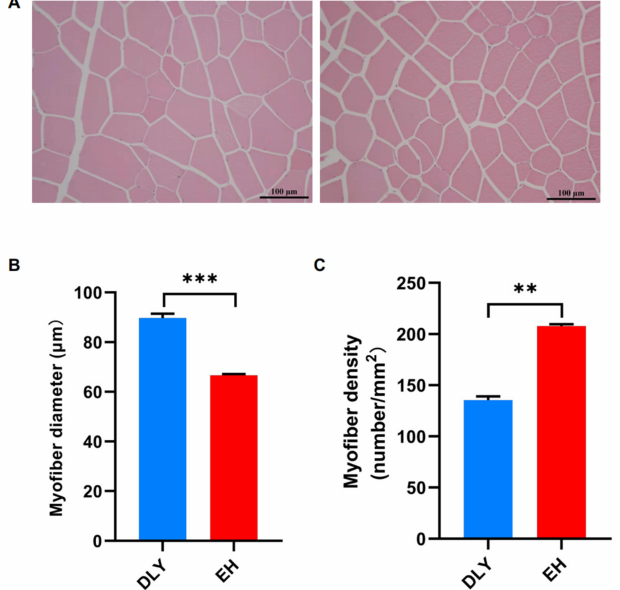
Figure 1. Fiber size of the longissimus dorsi of DLY and EH pigs. ( A ) HE staining (original magnifica- tion, × 200) showed the fiber size of the longissimus dorsi of DLY (left) and EH pigs (right). ( B ) Fiber diameters and ( C ) densities of the longissimus dorsi . The data were expressed as means ± SEM; ** p < 0.01 and *** p < 0.001.